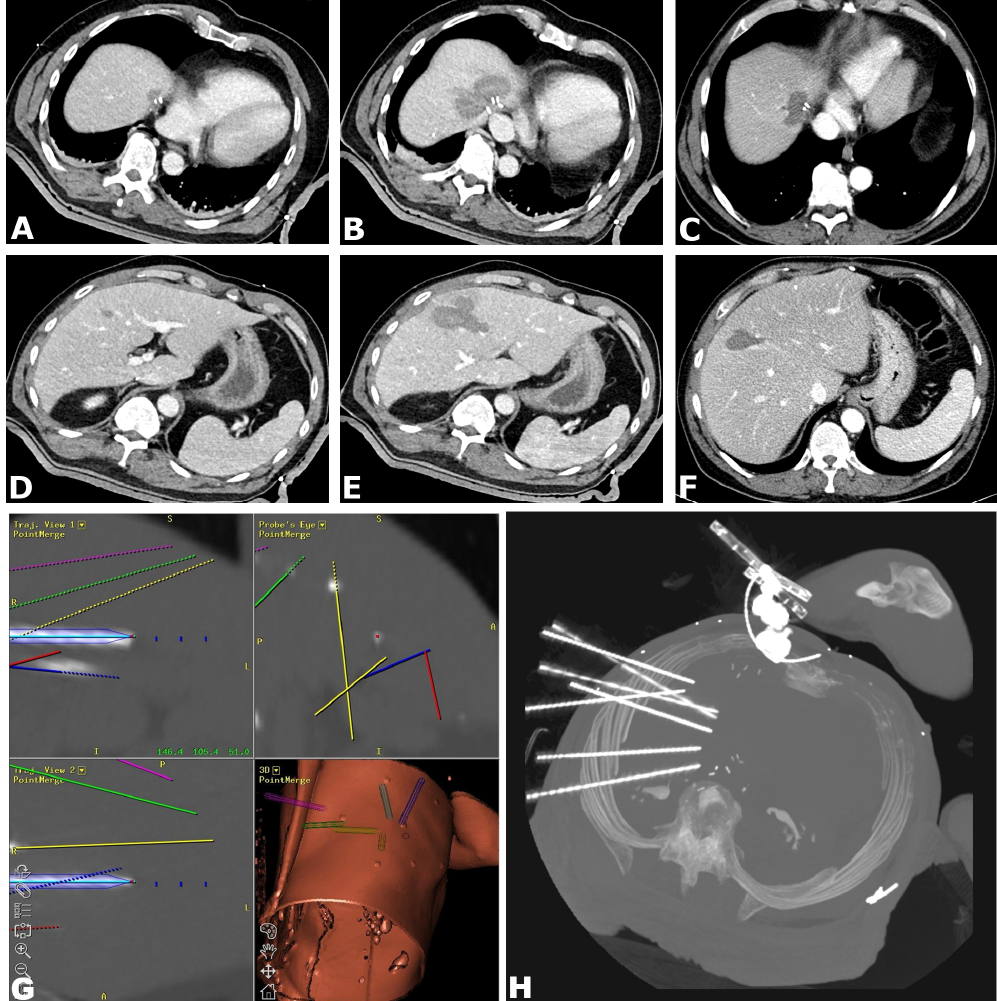
Figure 2. A 57-year old male with three colorectal cancer liver metastases (max 1.8 cm). ( A ) CT-image of the contrast-enhanced planning CT scan with a 1.8 cm recurrent metastasis following hepatic resection close to the central hepatic veins. ( B ) Immediate post-ablation and ( C ) 12-month contrast-enhanced CT scans showing no evidence of residual or recurrent disease. ( D ) Contrast-enhanced planning CT image showing a further 1.5 cm metastasis in segment V. ( E ) Immediate post-ablation and ( F ) 12-month CT scan showing no evidence of residual or recurrent disease. ( G ) Images from the navigation system depicting fused CT images of the needle control and planning scans with an example of a longitudinal planned trajectory (light blue) and the corresponding probe`s eye view (red dot) with perfect alignment. ( H ) maximum intensity projection image of the non- enhanced control CT scan showing all seven coaxial needles in position.